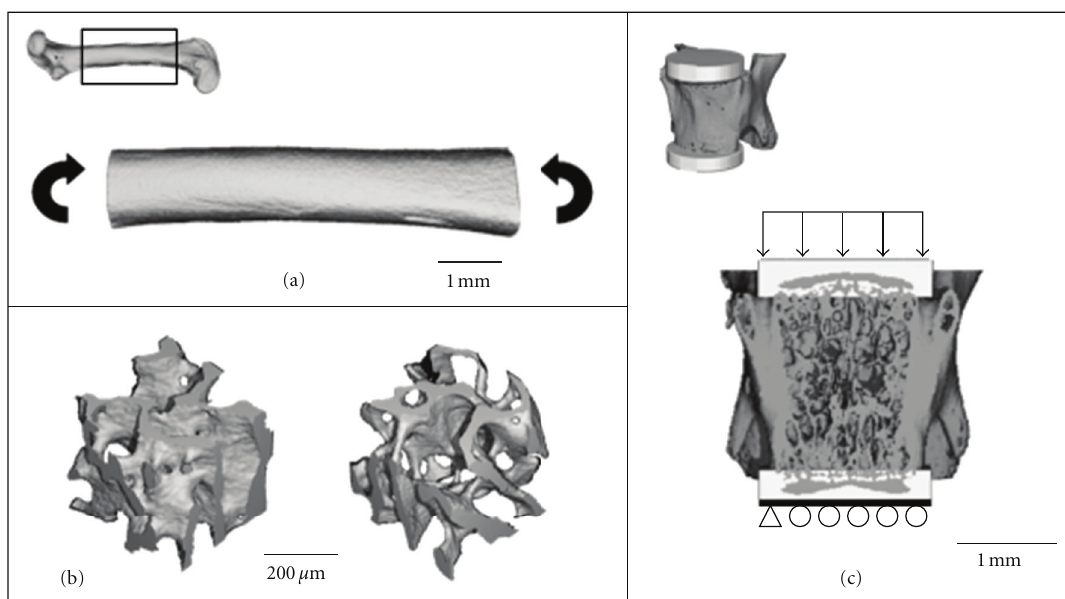
Figure 1: Finite element models. (a) Femur, positioned with condyles down, loaded in pure bending to an angle of 0.01 radians. (b) Cubes of trabecular bone extracted from the distal region of the L4 vertebral body. On the left, bone from the GH-su ffi cient mouse and, on the right, bone from a GH-deficient mouse are pictured, each with the median apparent modulus in their respective groups. (c) Vertebrae with endcaps digitally encasing the vertebral body endplates. Vertebrae were loaded in compression to 1%